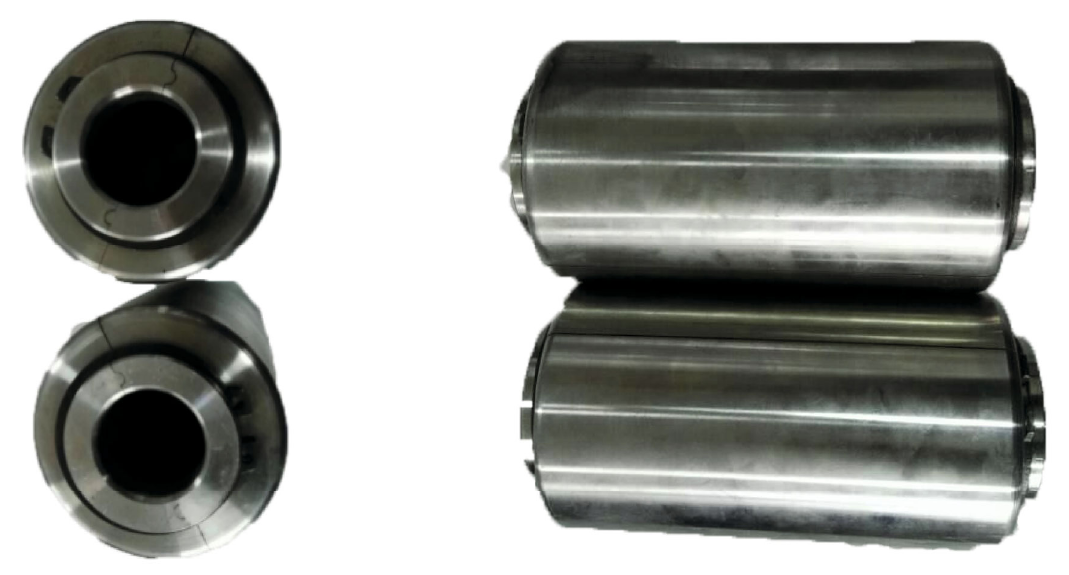
Figure 17: Ultra-high-pressure hose fi tting